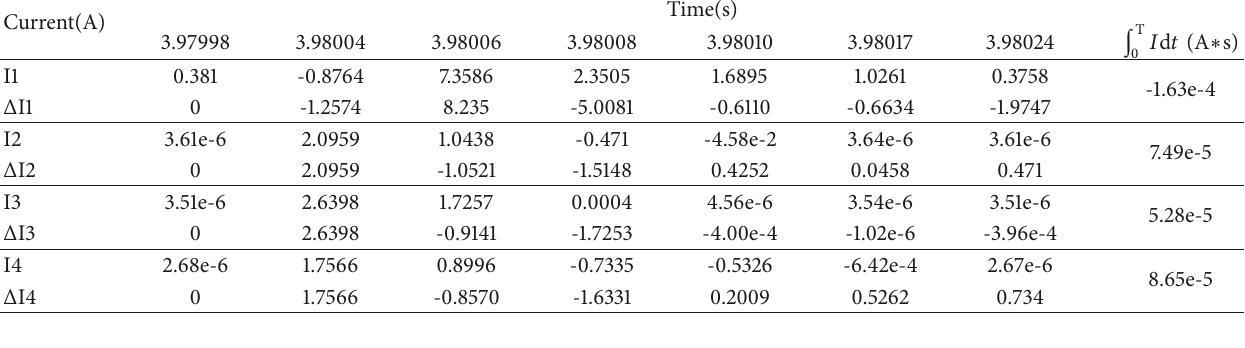
Table 3: Balancing current in one operation cycle for the ideal gating signal.